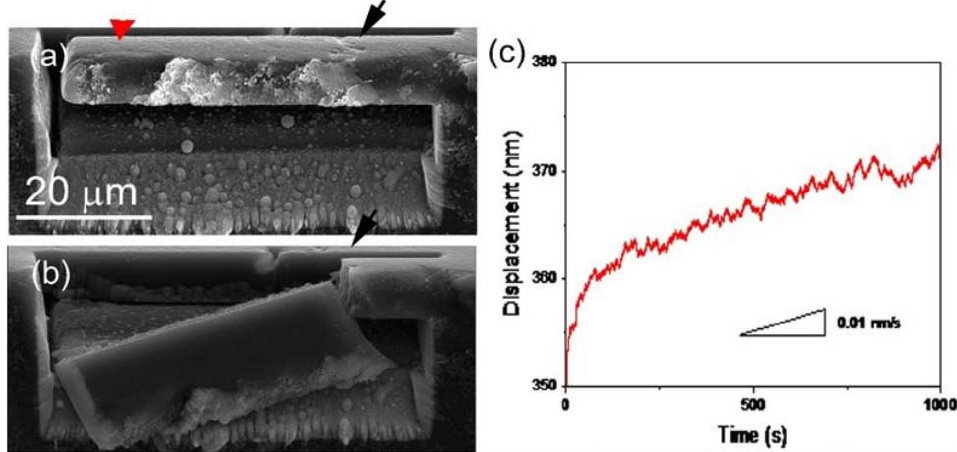
Figure 4. ( a ) SEM micrograph of representative n-B 4 C cantilever showing some nanopores (indicated by the black arrow) on the surface near the pivot. ( b ) SEM micrograph of fractured n-B 4 C cantilever upon indentation loading force of 6.145 mN at red arrow in Figure 4a. ( c ) The displacement–time curve of the n-B 4 C cantilever at constant loading of 5 mN shows permanent deformation with a slope of 0.01 nm/s. Reproduced with permission from [76]. Copyright 2022 APS.